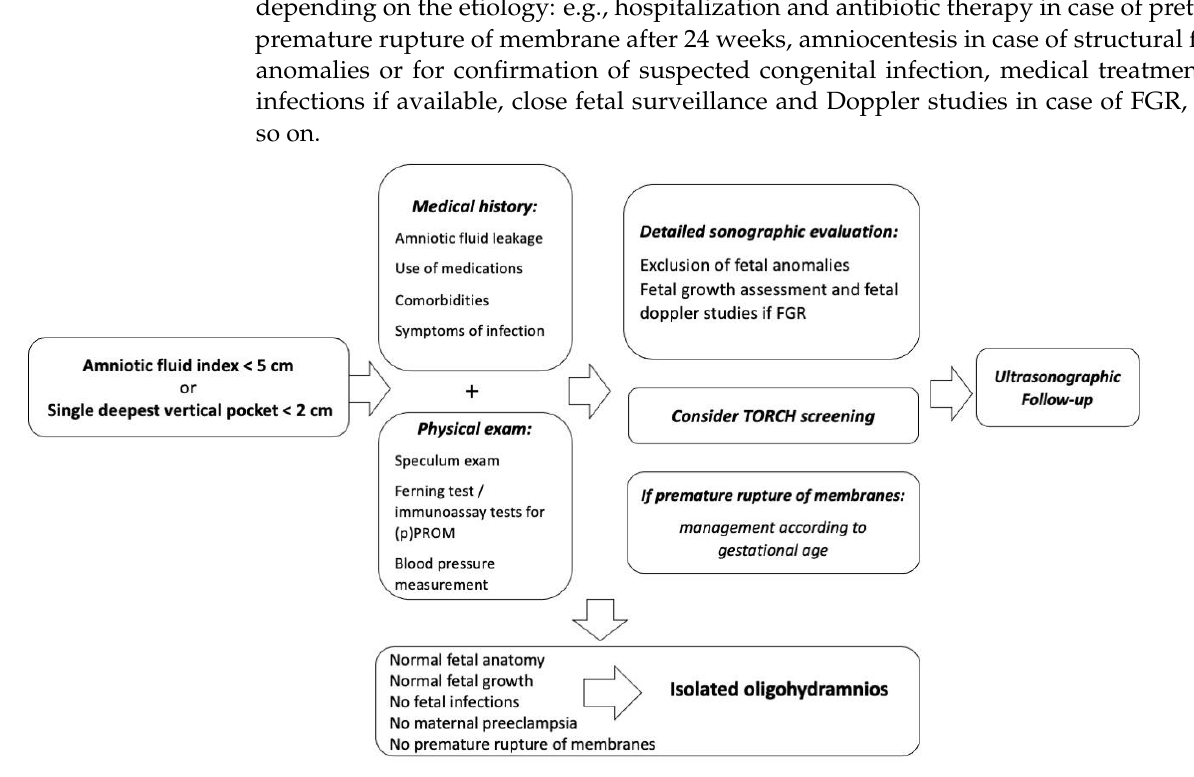
Figure 2. Diagnostic workup for cases of oligohydramnios.